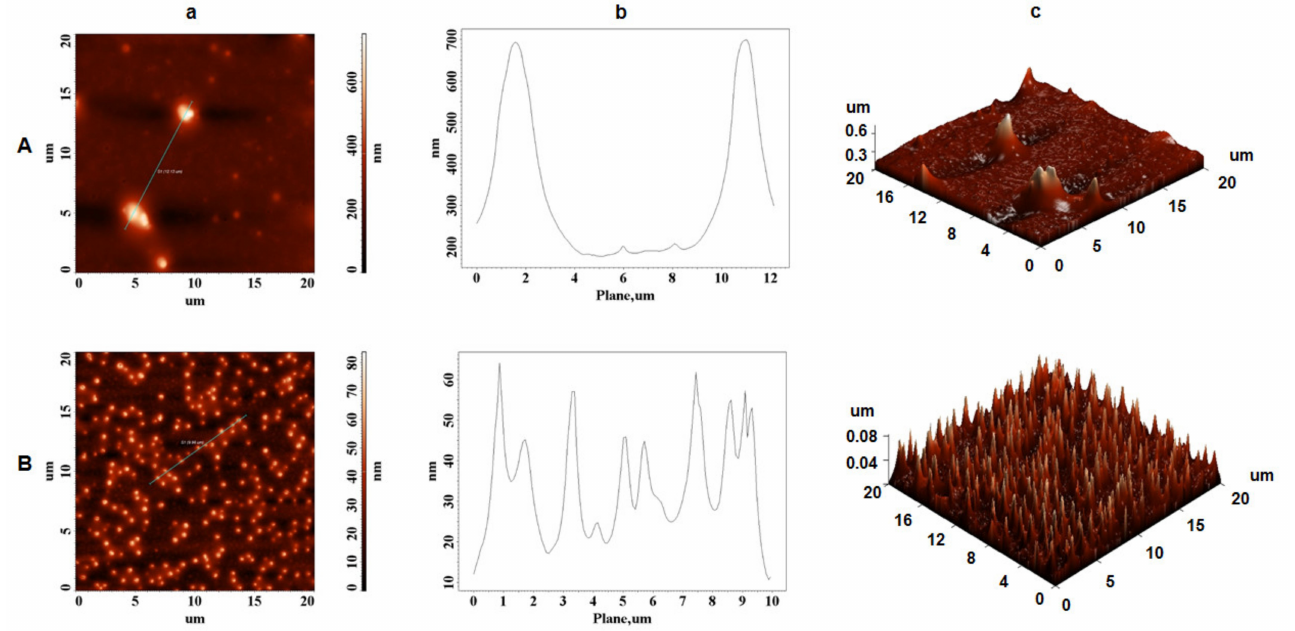
Figure 5. AFM images of extracted zein using ultrasonic homogenizer; ( A ) 95/250 (95% ethanol solution and 250 µ m flour granulation) and ( B ) 95/710 (95% ethanol solution and 710 µ m flour granulation); ( a ) height AFM images; ( b ) plot height distribution of particles along the profile line and ( c ) 3D AFM